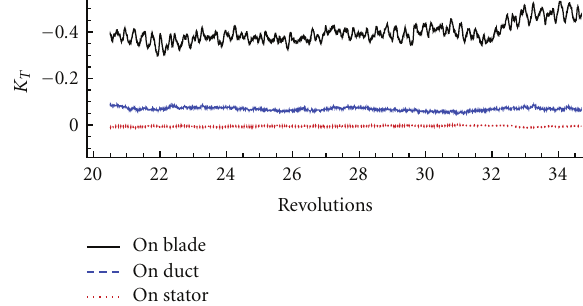
Figure 16: Time history of K T for ducted propulsor with stator blades.